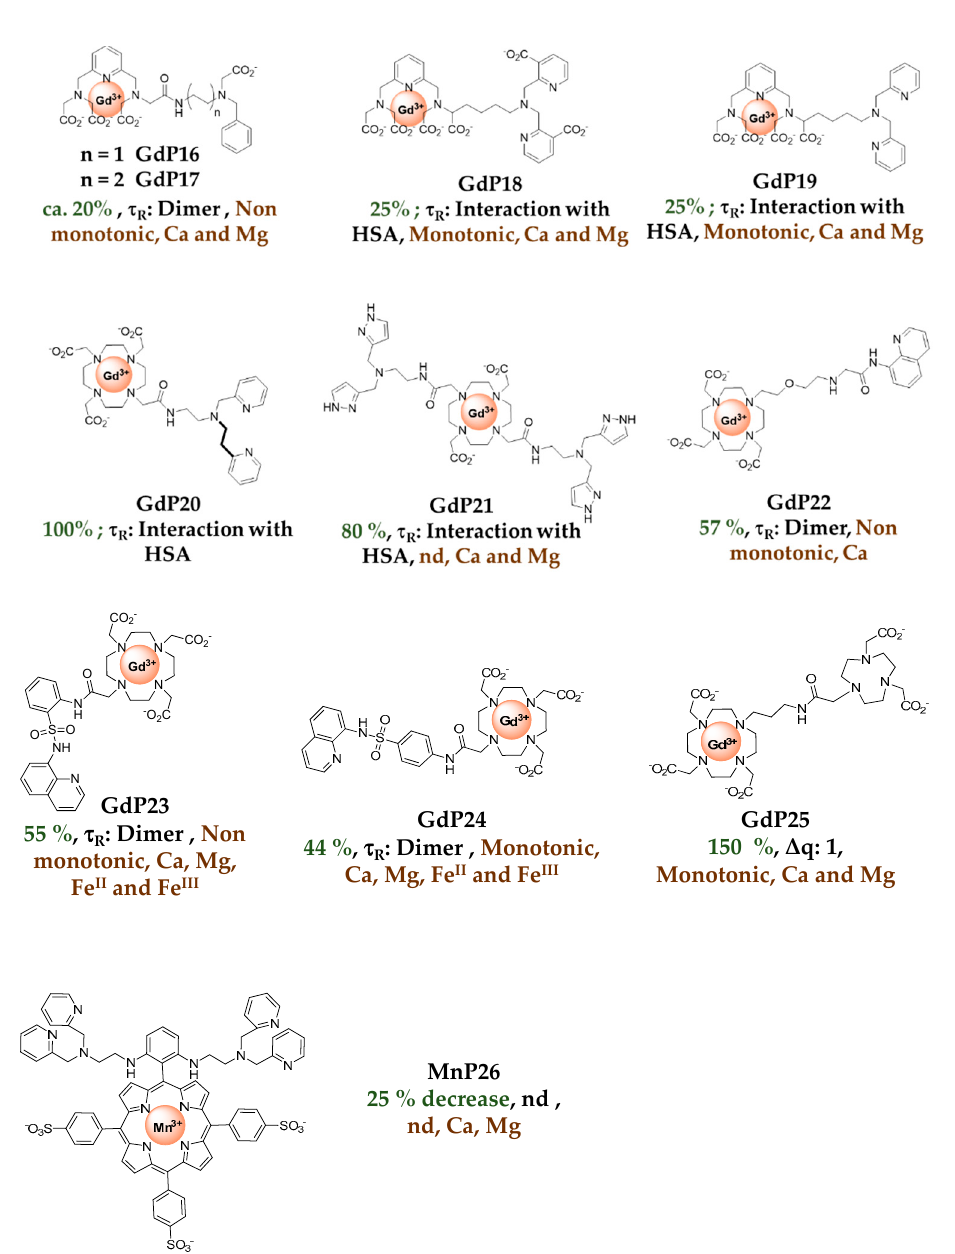
Figure 6. Metal-based complexes for Zn 2+ detection: In green (maximum Δ r 1 ), black (mechanism of Figure6. Metal-basedcomplexesforZn 2 + detection: Ingreen(maximum ∆ r 1 ),black(mechanismofresponse), response), brown (type of Zn 2+ response and selectivity). brown (type of Zn 2 + response and